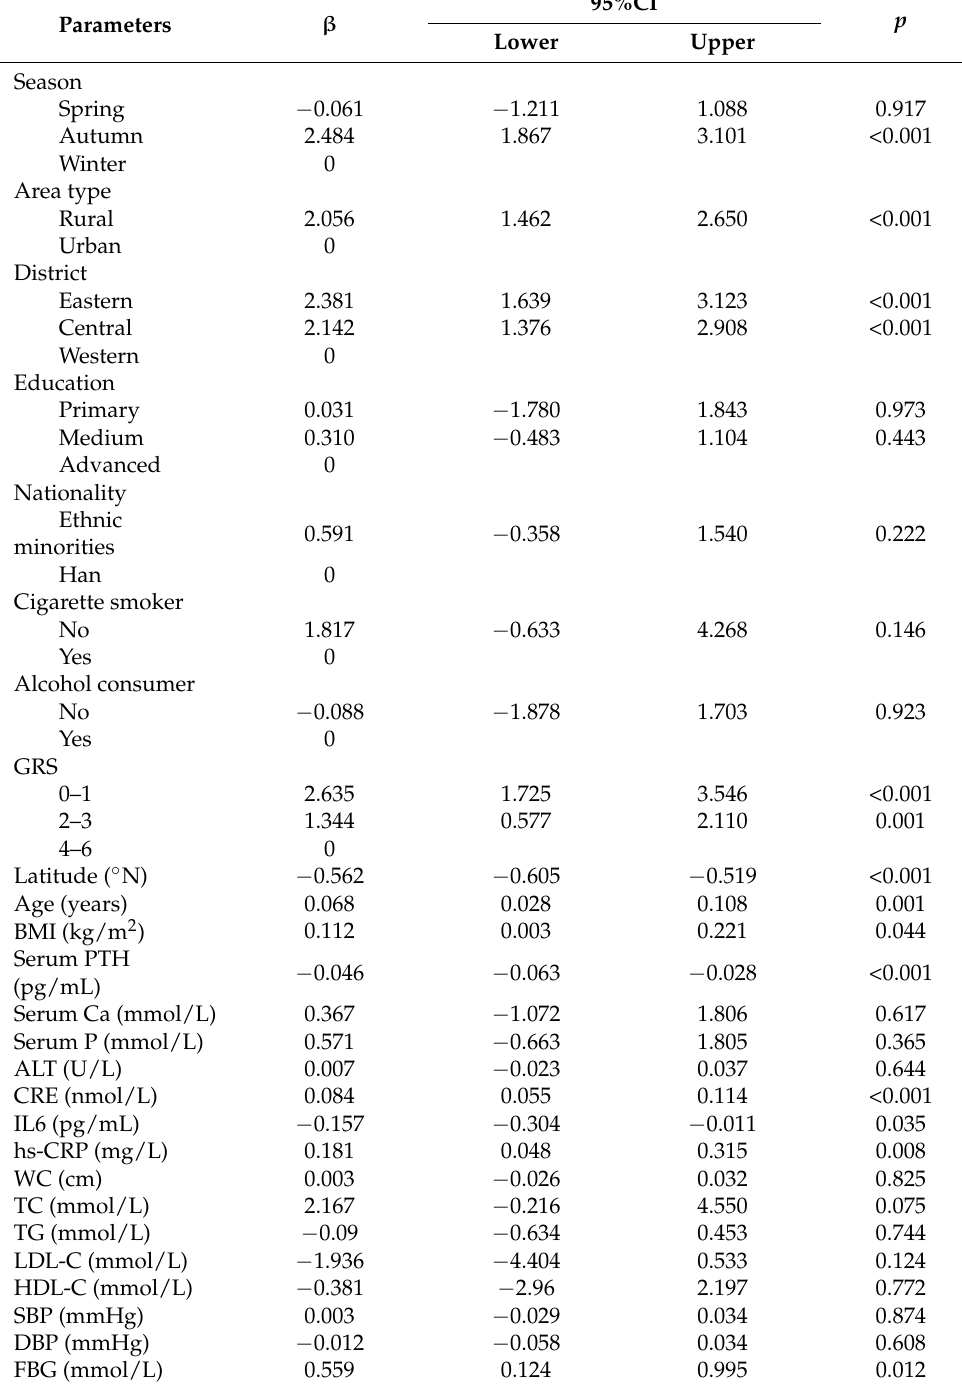
Table 4. Generalized linear model of the associations between serum 25(OH)D and related factors.